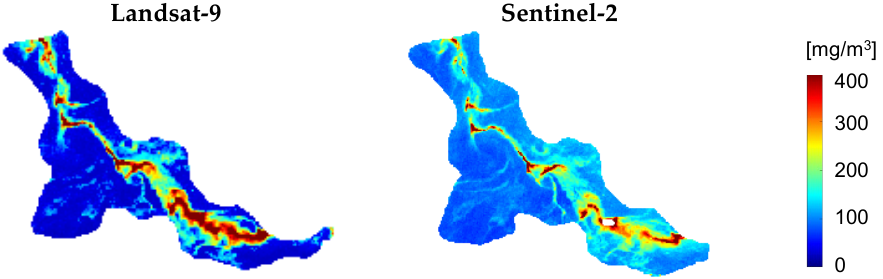
Figure 12. Chl-a map derived from Landsat-9 and Sentinel-2 imagery in Lake Varese. Example scatterplots analyzing the pixel-by-pixel TSM and Chl-a consistency between Landsat-9 and Sentinel-2 retrievals are shown in Figure 13 for Lake Trasimeno (16 December 2021). The consistency statistics for all multitemporal imagery of Lake Trasimeno and other case studies are reported in Table 3. For Lake Trasimeno, TSM maps show stronger agreement than Chl-a (average TSM R 2 of 0.89 vs. 0.74 for Chl-a excluding 24 January data that the images have one day gap). However, Chl-a retrievals are slightly less biased (on average ~10%) than TSM when comparing Landsat-9 to Sentinel-2. In other lakes,